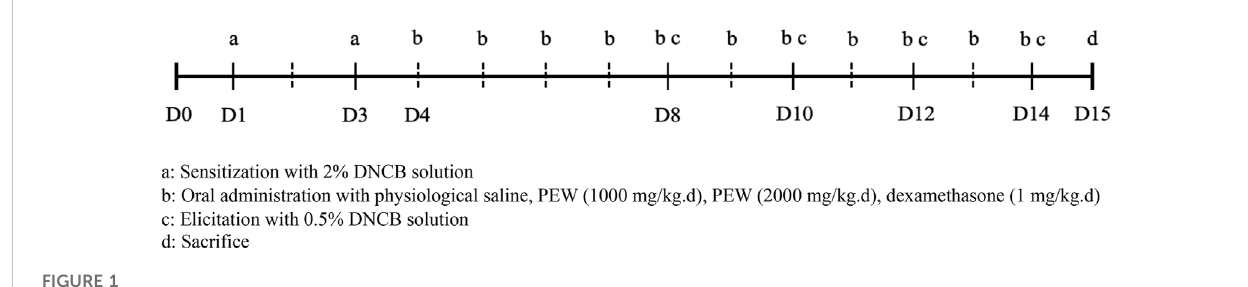
FIGURE 1 Schedule of the experiment. All mice were shaved about 2.5 cm × 2.5 cm on their dorsal skin on day 0. On day 1, the mice were fi rst sensitized by painting with 120 μ L of 2% DNCB solution on shaved dorsal skin and 25 μ L on the back of the right ear. The same treatments were performed for the second sensitization on day 3. Four days later, the elicitation phase was induced by painting with 0.5% DNCB solution on the dorsal skin (120 μ L) and the backoftherightear(25 μ L)onceevery2 daystillday14.Allmiceweresacri fi cedonday15.Oraladministrationtreatmentswereconductedfromday 4 to day 14.